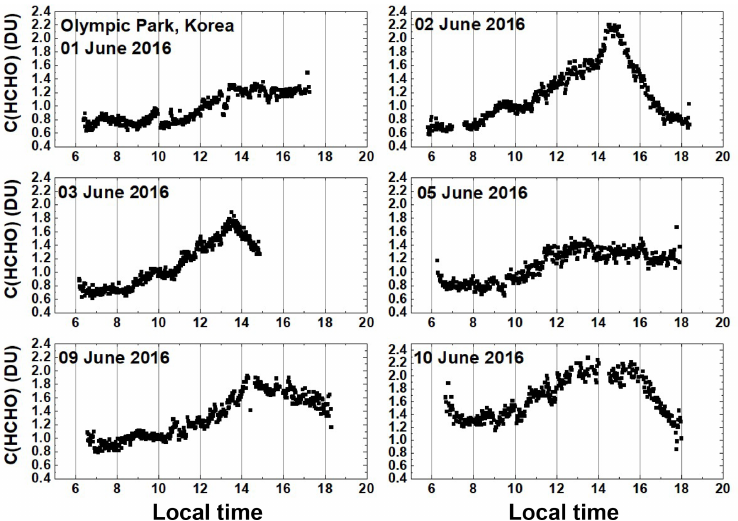
Figure 12. C(HCHO) from PSI at Olympic Park for 6 days in June 2016. C(HCHO) on 2 June 2016 has a peak value of 2.3DU at 14:30KST.